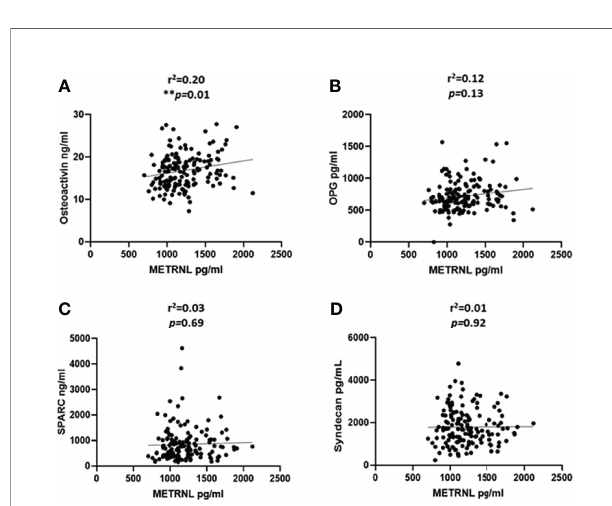
FIGURE 3 | Correlation analysis between METRNL and various molecules associated with bone remodeling. (A) Osteoactivin, (B) Osteoprotegerin (OPG), (C) Osteonectin (SPARC), (D) Syndecan-4 levels in plasma. Performed on the non-diabetic individuals age adjusted. METRNL level in plasma was determined using enzyme linked immunosorbent assay (ELISA), the circulating level of various osteogenic molecules were determined using a customized multiplex bone panel. Diabetes was de fi ned by fasting plasma glucose ≥ 126mg/L (7mmol/L). Spearman correlation coef fi cient was used to determine the association of METRNL with the different osteogenic factors. Statistical assessment was 2-sided and considered statistically signi fi cant at **p ≤ 0.01.